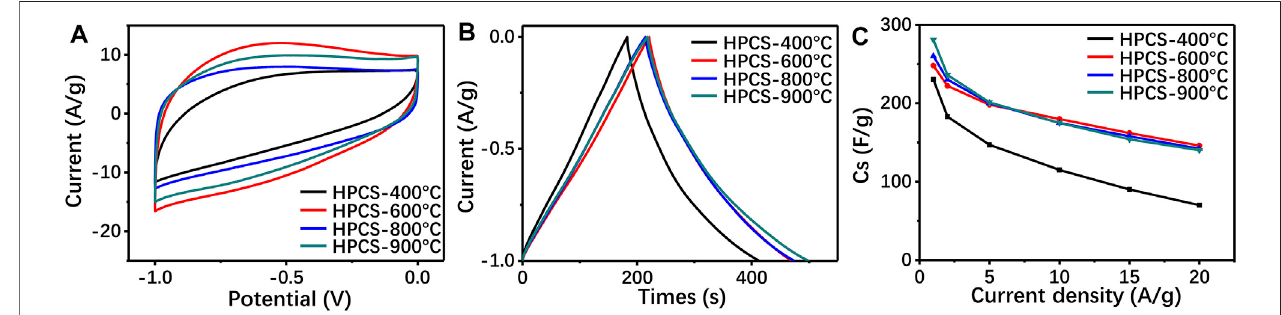
FIGURE 8 | the CV curves (100 mV/s) (A) , GCD curves (1 A/g) (B) and speci fi c capacitance of the Cu/GG derived porous carbon with different concentration of Cu 2+ ; the CV curves (100 mV/s) (d), GCD (e) curves (1 A/g) and speci fi c capacitance of Cu/GG hydrogel derived carbon prepared under different carbonization